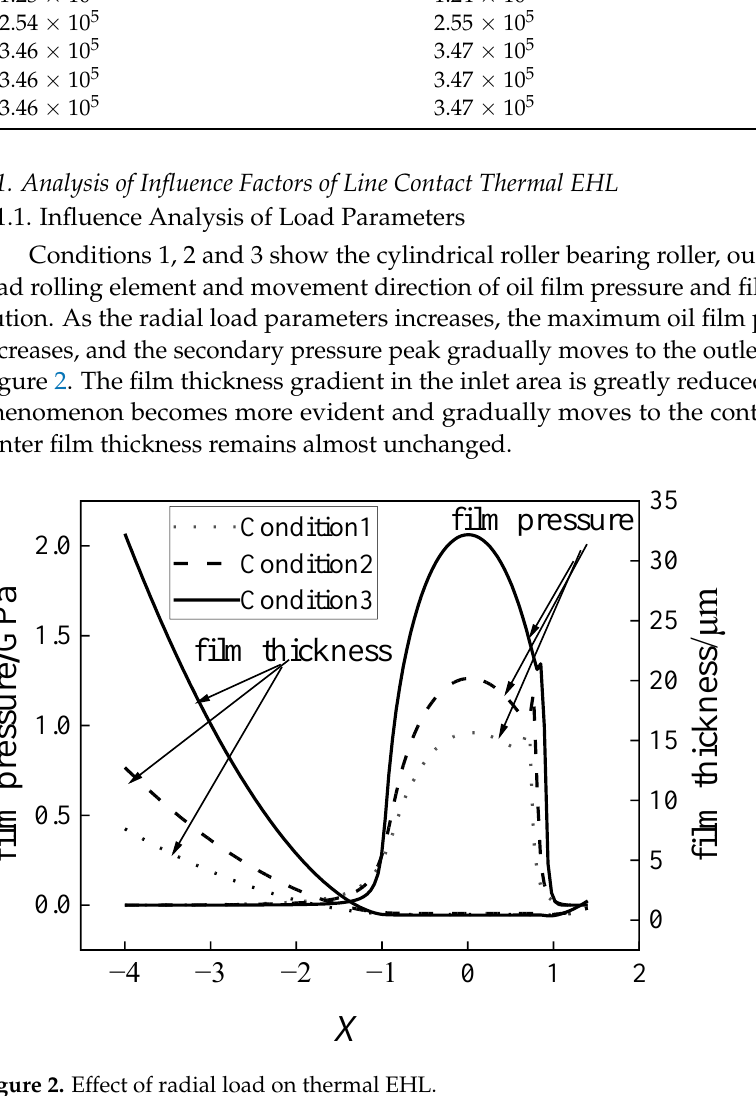
Figure 2. Effect of radial load on thermal EHL.